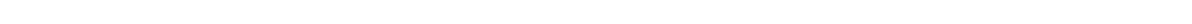
Fig. 8 PIXR in fl uences the tick gut metabolome and impacts B. burgdorferi gene expression. a Heat map showing alterations in the pro fi le of differentially represented gut metabolites between ticks fed on PIXR-immunized (PIXR 1 and 2-each sample representing a pool of 10 tick guts) or ovalbumin-immunized mice (controls 1 and 2 each-sample representing a pool of 10 tick guts) in the positive and negative mode. Normalized signal intensities are shown as a color spectrum, green indicating low abundance and red indicating high abundance (least to abundant from − 1 to +1); qRT-PCR assessment of the expression levels of B. burgdorferi genes: b bb0690 ; c bbb29 ; d bba62 ; e ospA ; f bba74 ; and g rpoS in larvae fed on B. burgdorferi -infected ovalbumin- immunized (control) or rPIXR-immunized mice (PIXR). Horizontal bars represent medians. Mean values signi fi cantly different in a non-parametric Mann – Whitney test ( P < 0.05)